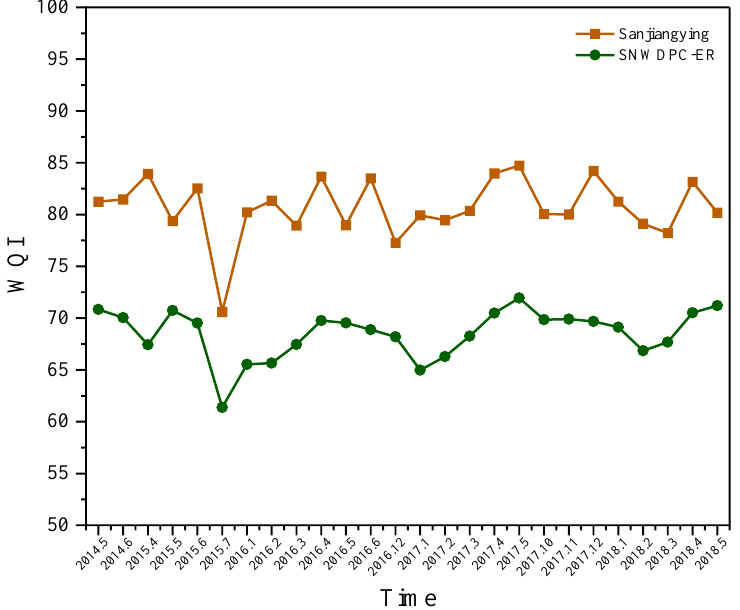
Figure 7. Graph of the WQI for each water quality parameter during 2014 – 2018.